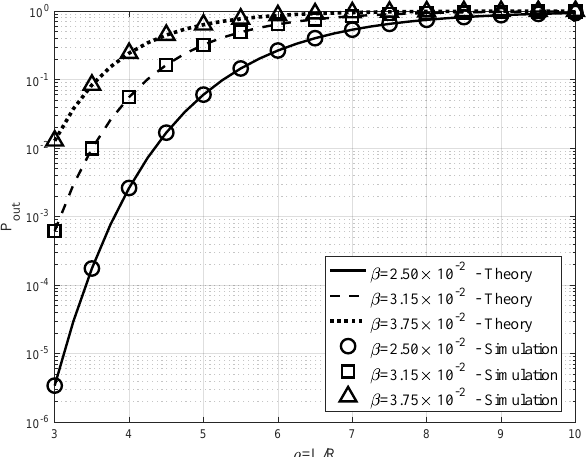
Figure 6. Outage rate versus ρ = L / R with λ = 10 − 3 R = 30m, and β = { 2.5 × 10 − 2 , 3.15 × 10 − 2 , 3.75 × 10 − 2 }